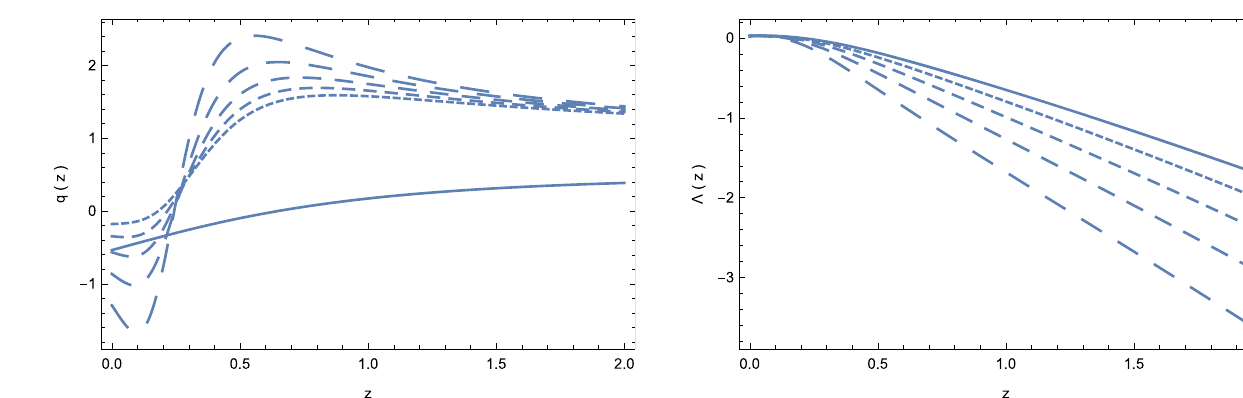
(cid:12) (cid:11) ˜ Q , ˜ T =